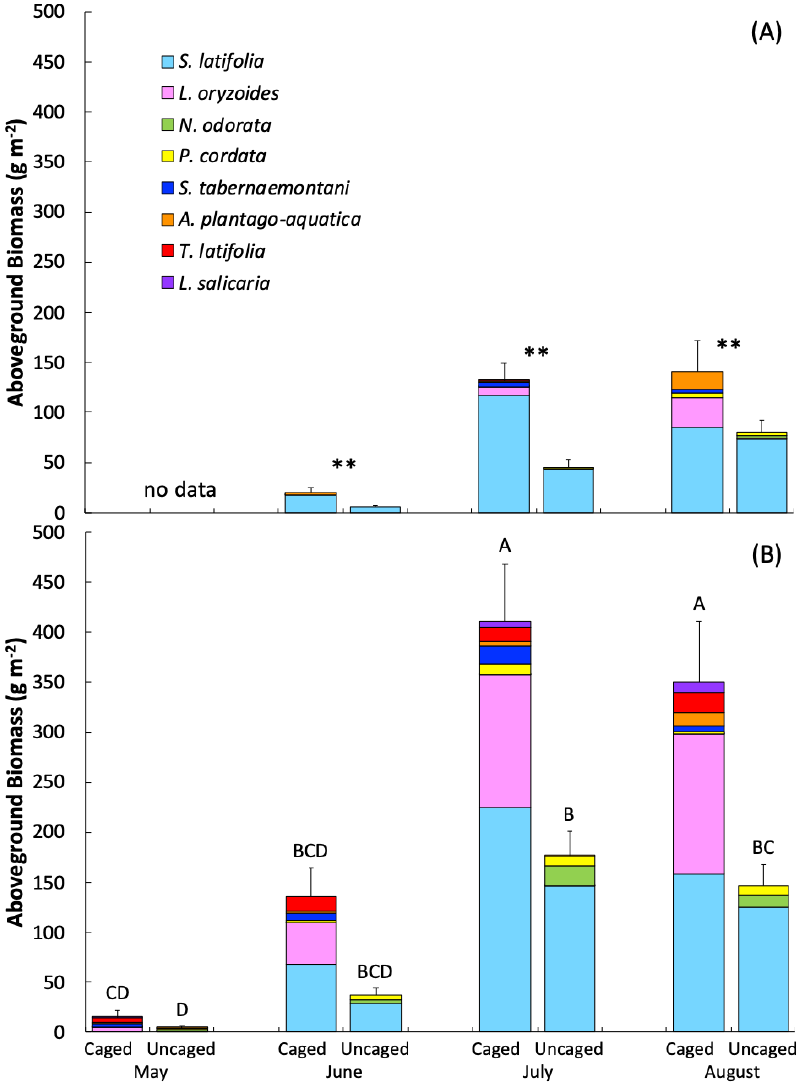
Figure 2. Aboveground biomass of dominant species during the ( A ) 2017 and ( B ) 2018 growing season for caged and uncaged treatments. Biomass of minor species, with no value > 2% of the total biomass in any season were excluded. These species are: Potamogeton crispus , Echinochloa crus-galli , Polygonum persicaria , and Carex sp. Error bars are the standard error for the total biomass in each season and treatment (n = 16). Stars indicate significant differences between grazer treatments (** p < 0.001) for 2017 where no interaction between season and treatment was found. Unique letters above bars in 2018 indicate statistically distinct values for the interaction between grazer treatment and season ( p <